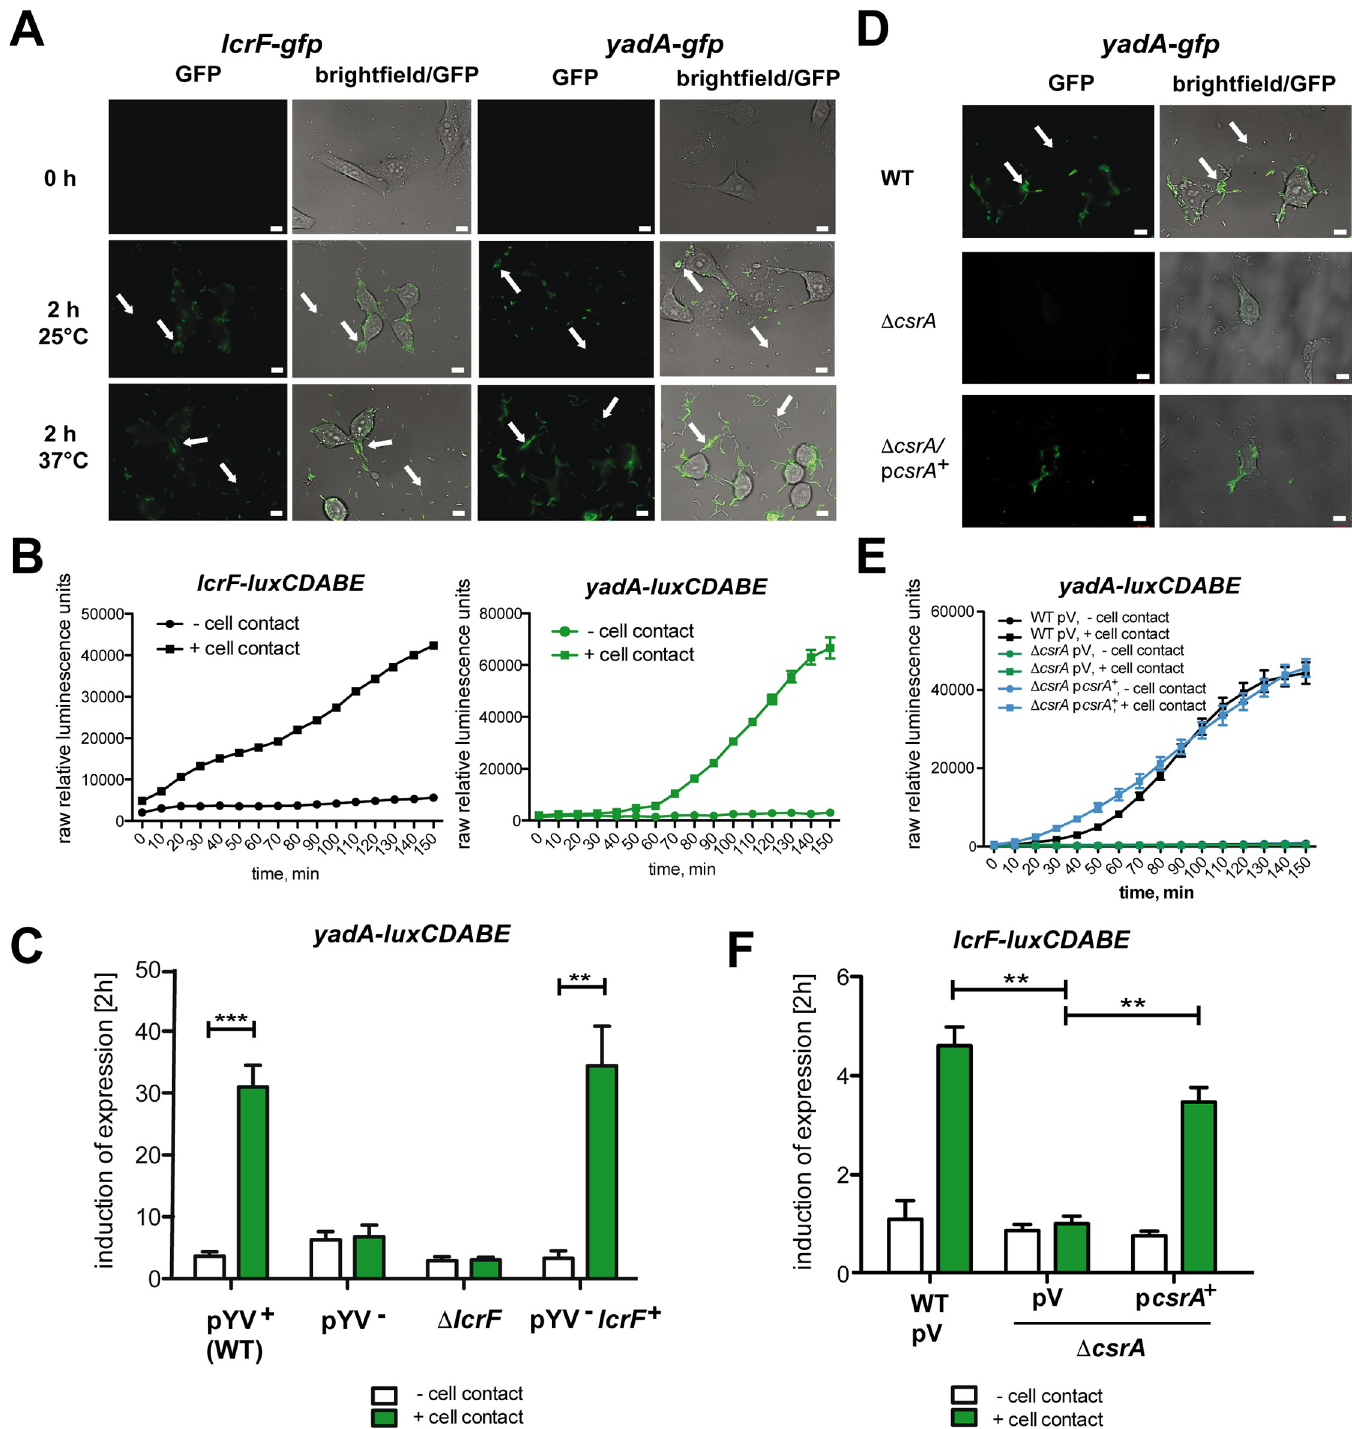
Fig 1. CsrA-dependent, host cell contact-mediated induction of yadA and lcrF expression. (A) HEp-2 cells infected with Y . pseudotuberculosis wildtype strain YPIII harboring a plasmid-encoded yadA-gfp (pJE9) or a lcrF-gfp fusion (pWO3) were incubated for at least 2 h at 25˚C or 37˚C. Arrows indicate bacteria in contact and without contact to host cells. White bars indicate 5 μ m. (B) Strain YPIII harboring a plasmid-encoded yadA-luxCDABE (pWO41) or a lcrF-luxCDABE fusion (pWO42) were incubated with or without HEp-2 cells for 2.5 h at 25˚C. Bioluminescence of the samples was monitored every 10 min to determine the kinetics of host cell contact- dependent expression of the reporter fusions. (C) Strains YPIII (WT), YP12 (pYV - ), YP66 ( Δ lcrF ) and YP155 (pYV - , lcrF + ) harboring the yadA-luxCDABE fusion plasmid pTS31 were used to infect HEp-2 cells or were incubated in PBS incubated without cells at 25˚C. Bioluminescence of the samples was monitored after 2 h. The data